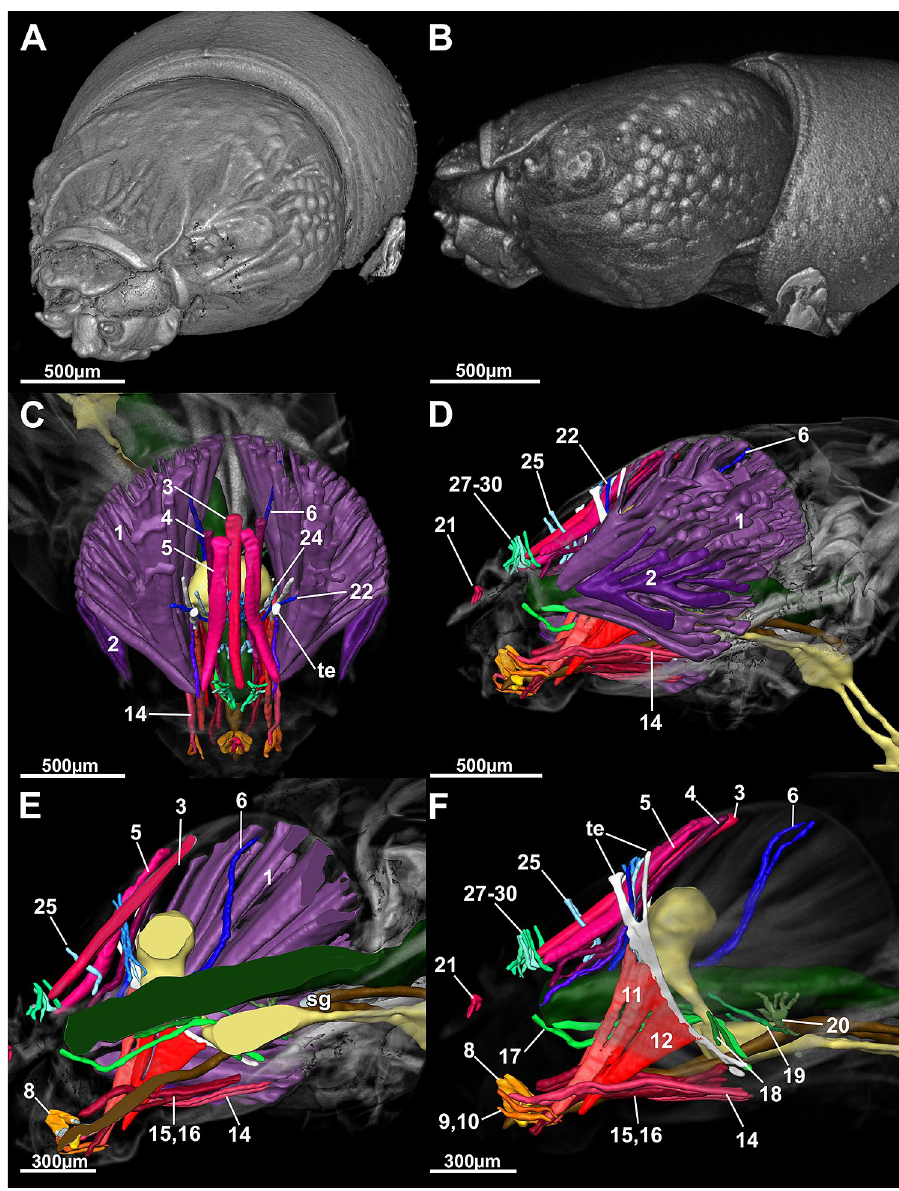
Figure 3. 3D-reconstruction of the morphology ( A , left fronto-lateral view, B , lateral view) and the internal head anatomy ( C , frontal view, D , lateral view, E , sagittal view, F , parasagittal plane at the level of the tentorium) of Drusus franzi (5th larval instar) based on µCT data. Abbreviations: 1 = Musculus (M.) cranio-mandibularis medialis, 2 = M. cranio-mandibularis lateralis, 3 = M. fronto-labralis, 4 = M. fronto-pharyngalis, 5 = M. fronto- epipharyngalis, 6 = M. cranio-postpharyngalis dorsalis, 7 = M. praemento-salivaris, 8 = M. hypopharyngo- salivarialis, 9. = M. basistipito-dististipitalis lateralis, 10 = M. basistipito-dististipitalis medialis, 11 = M. tentorio- stipitalis, 12 = M. tentorio-cardinalis, 14 = M. cranio-dististipitalis, 15 = M. cranio-praementalis medialis, 16 = M. cranio-praementalis lateralis, 17 = M. cranio-cibarialis, 18 = M. cranio-pharyngalis anterior, 19 = M. cranio- pharyngalis posterior, 20 = M. cranio-postpharyngalis ventralis, 21 = M. labro-epipharyngalis, 22 = M. cranio- pharyngalis lateralis, 23 = M. fronto-pharyngalis medialis, 24 = M. fronto-pharyngalis lateralis, 25 and 26 = M. fronto-pharyngalis ventralis, 27 and 28 = M. clypeo-pharyngalis, 29 and 30 = M. clypeo-cibarialis, te = tentorium. The figure was built using the visualization software Amira 2020.2 (Thermo Fisher Scientific, https:// www. therm ofish er.